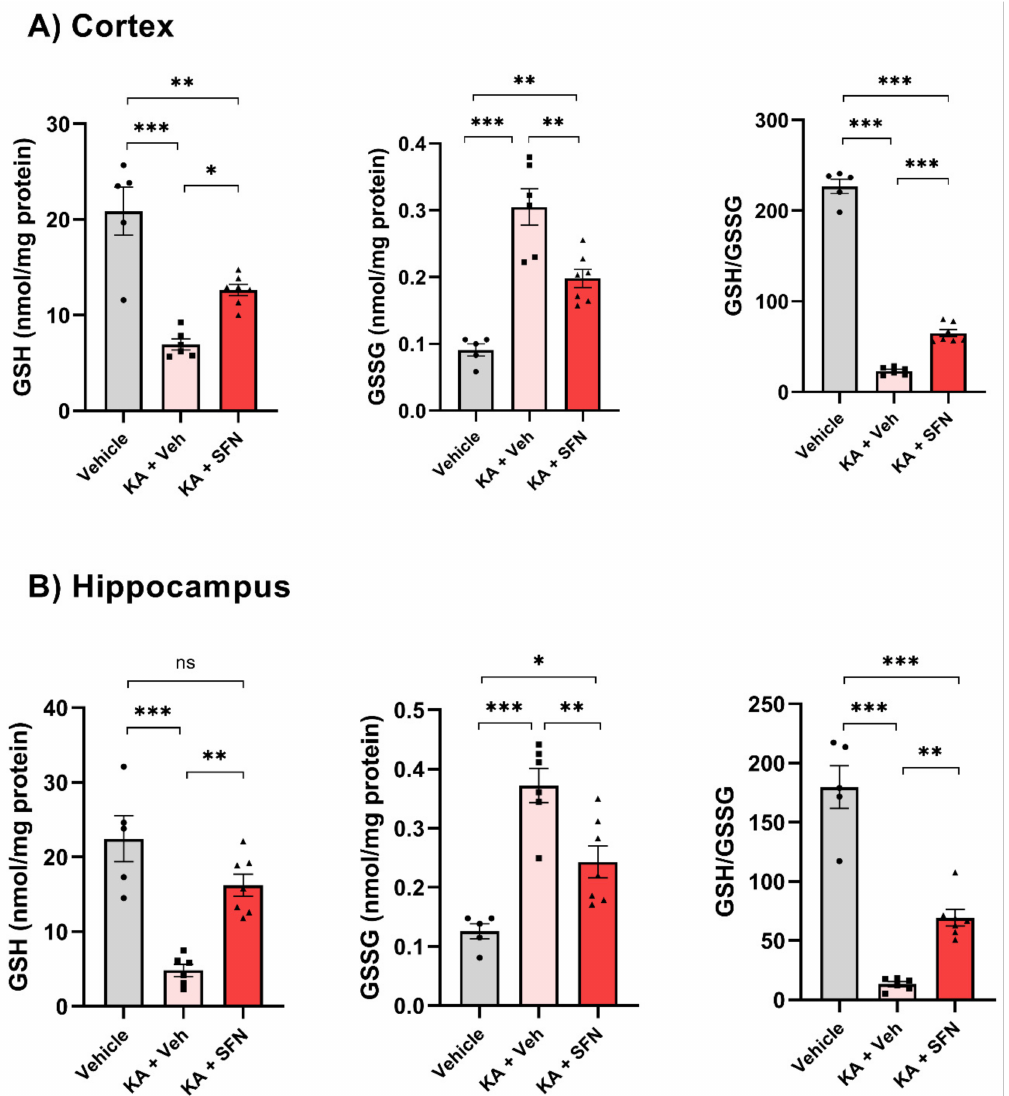
Figure 3. SFN improves oxidative stress markers following in vivo SE. Reduced (GSH) and oxidized (GSSG) glutathione levels, and their ratio (GSH/GSSG) in the cortex ( A ) and hippocampus ( B ) of sham-operated rats (treated with vehicle, n = 5) and rats subjected to KA-induced SE treated with either vehicle ( n = 6) or SFN (5 mg/kg/day over 5 days, n = 7), and sacrificed 7 days after SE onset. Data were analysed by one-way ANOVA followed by Tukey’s multiple comparisons test. Bars represent the mean ± SEM, (* p < 0.05, ** p < 0.01, and *** p <